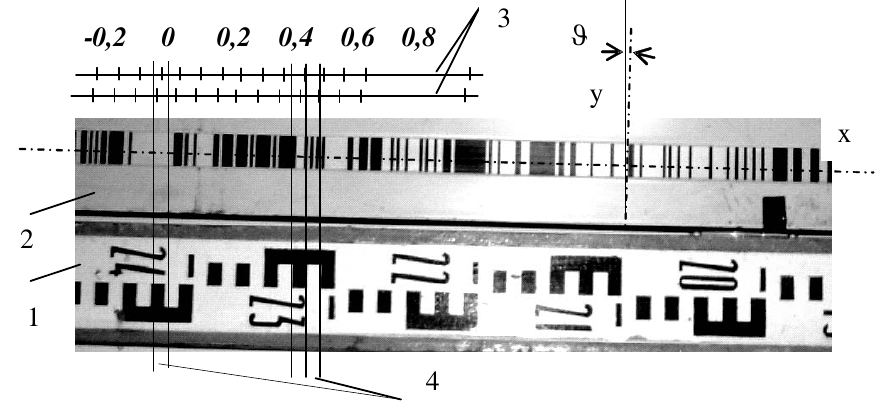
Fig 1. General view of photogrametric calibration of levelling meters: 1 – standard meter, 2 – meter to be calibrated, 3 – linear and vernier scale for readings, 4 – moving